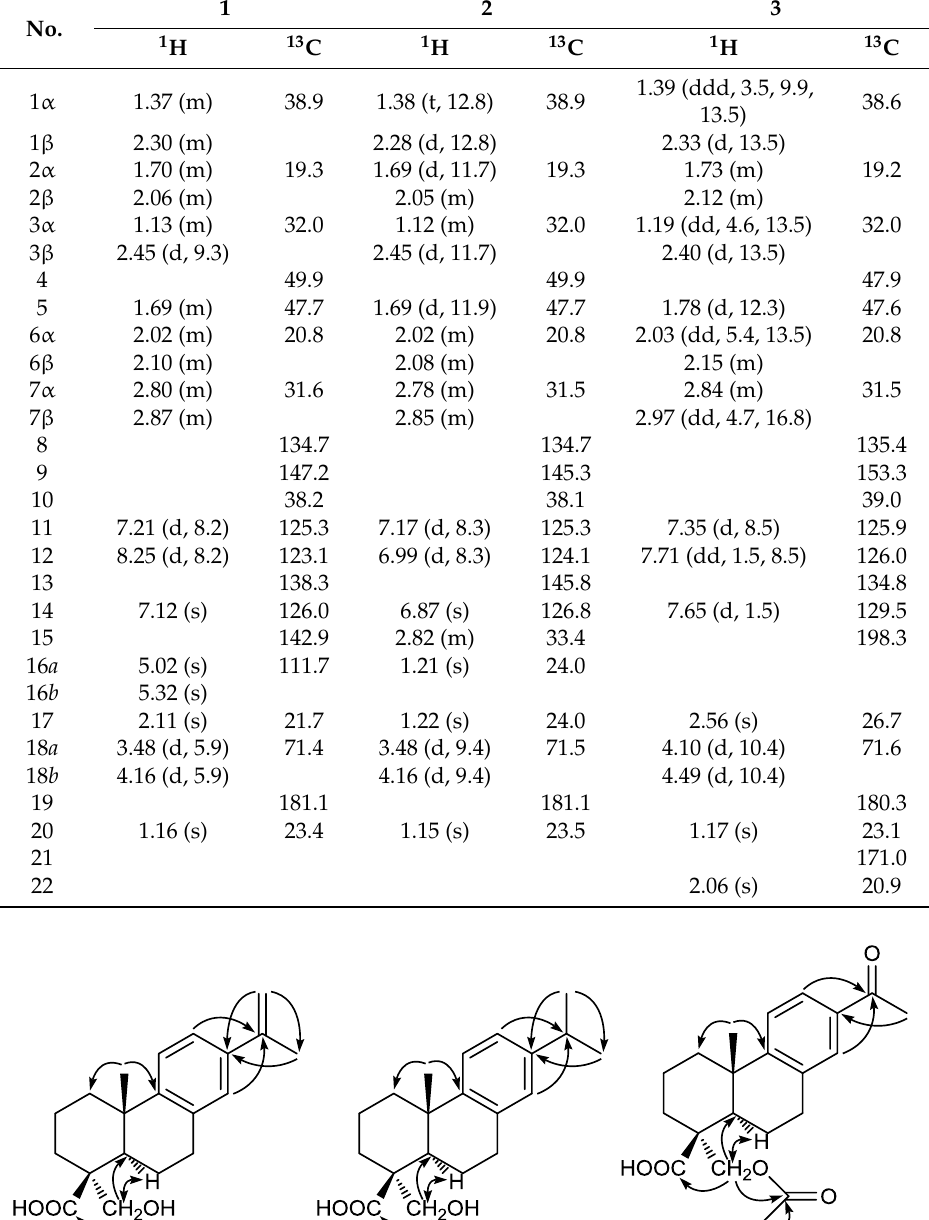
Table 1. 1 H- (600 MH Z ) and 13 C-NMR (150 MH Z ) data of compounds 1 – 3 (CDCl 3 ).